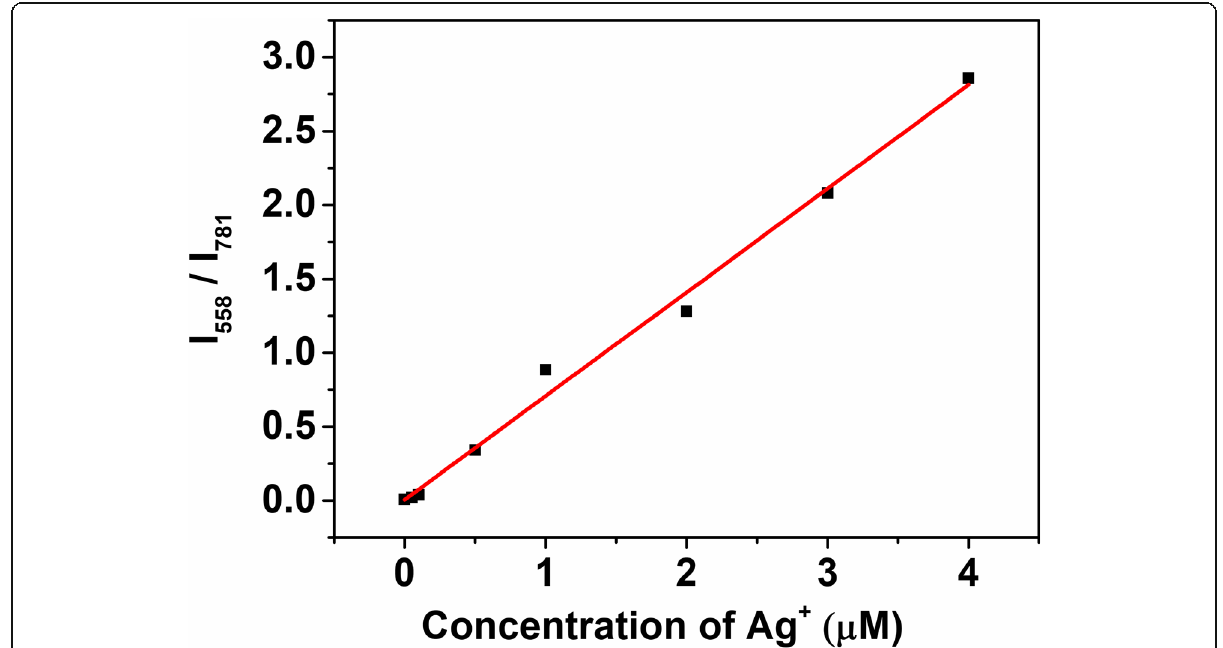
Fig. 3 The curve is plotted with the fluorescence intensity ratio (I 558 /I 781 ) versus Ag + concentration